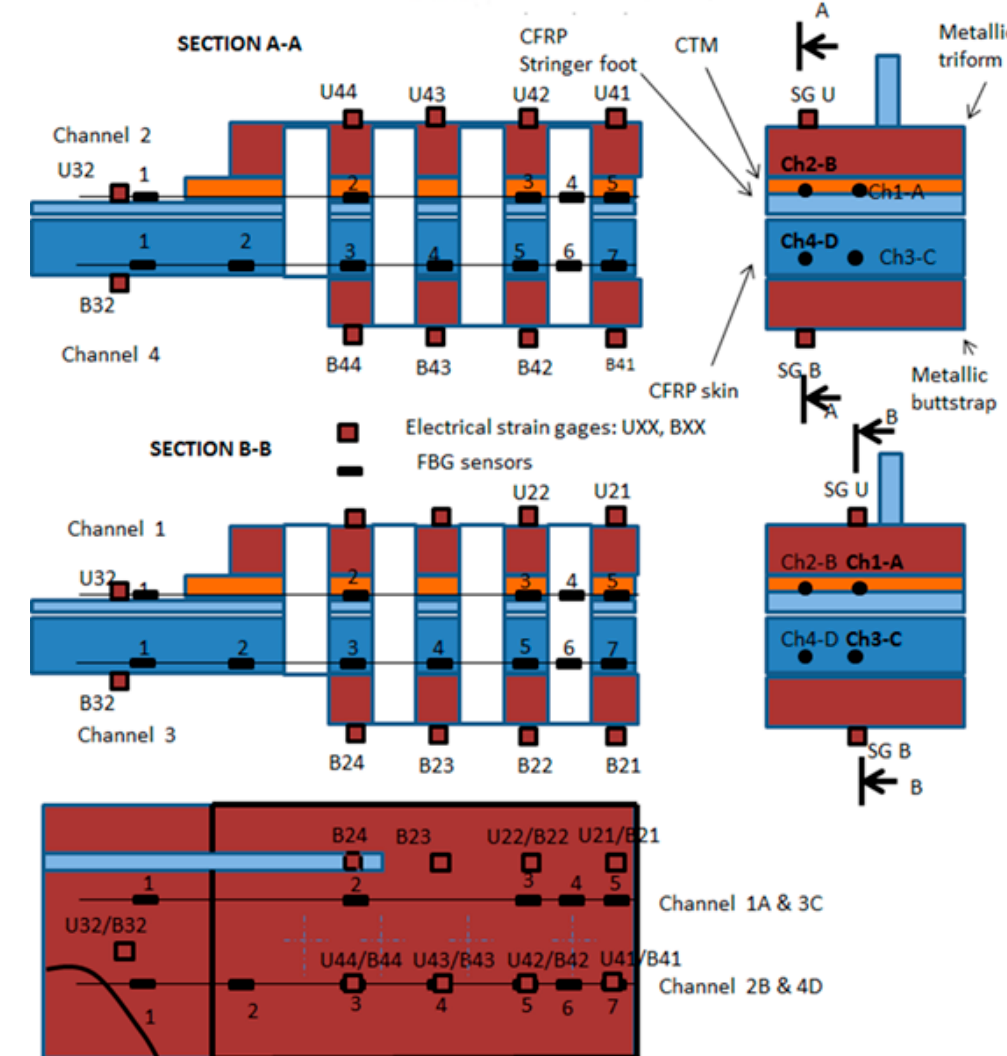
Figure 7. Locations of the strain gauges and FBG sensors.